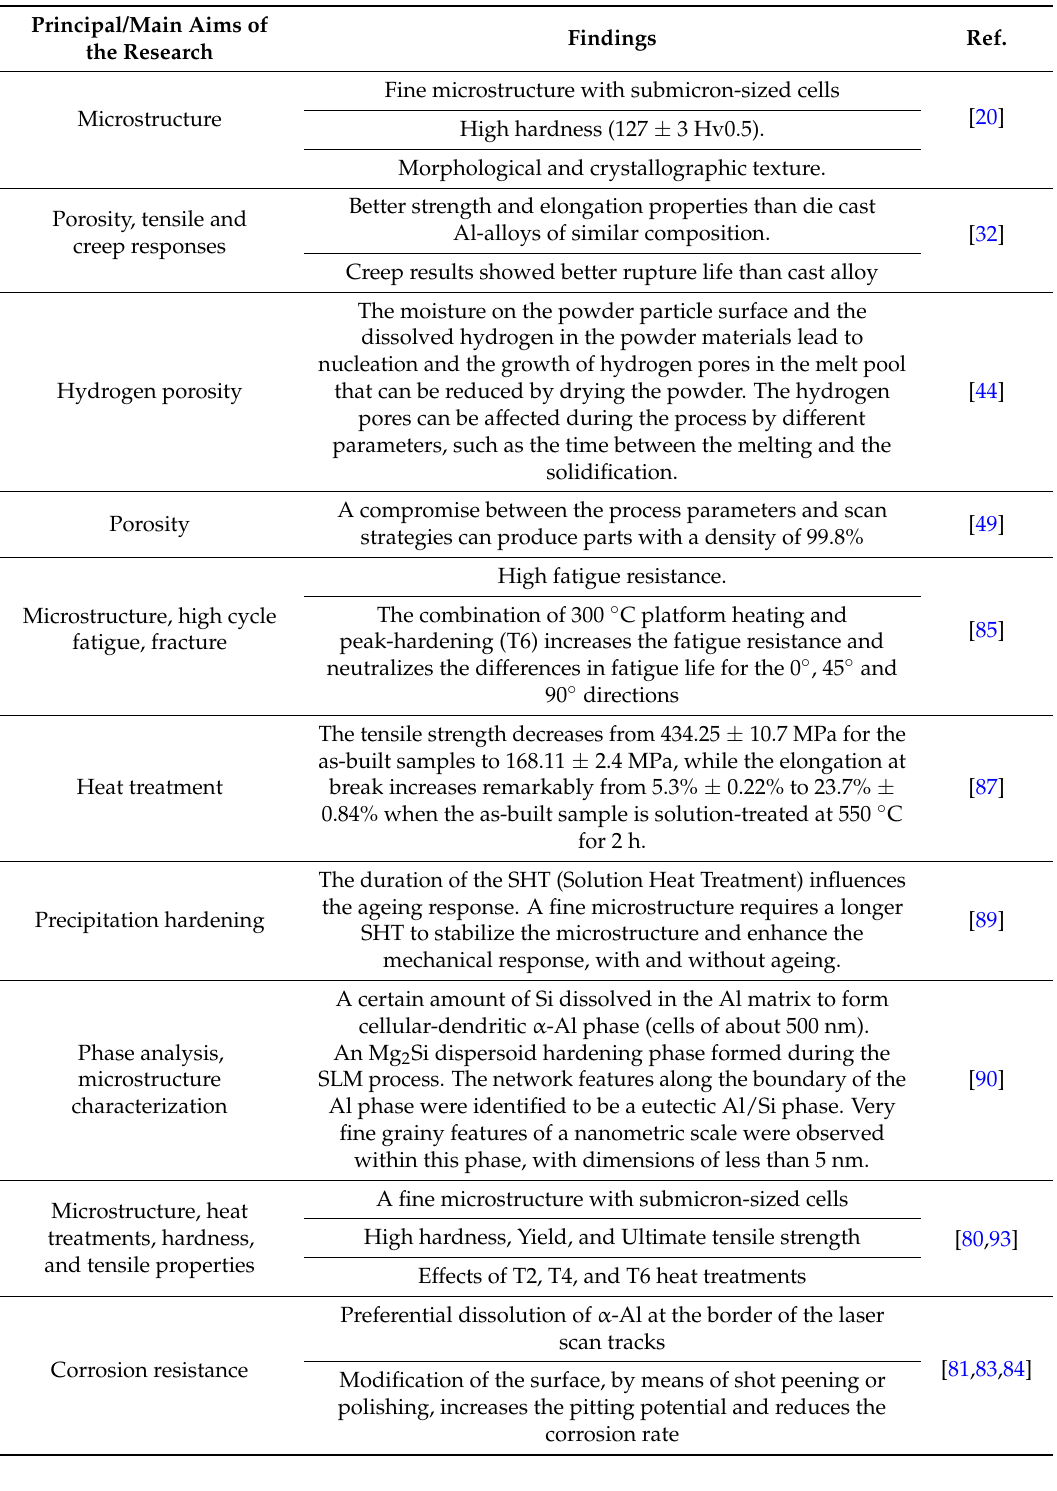
Table 2. The main recent studies focused on AlSi10Mg alloy processed by